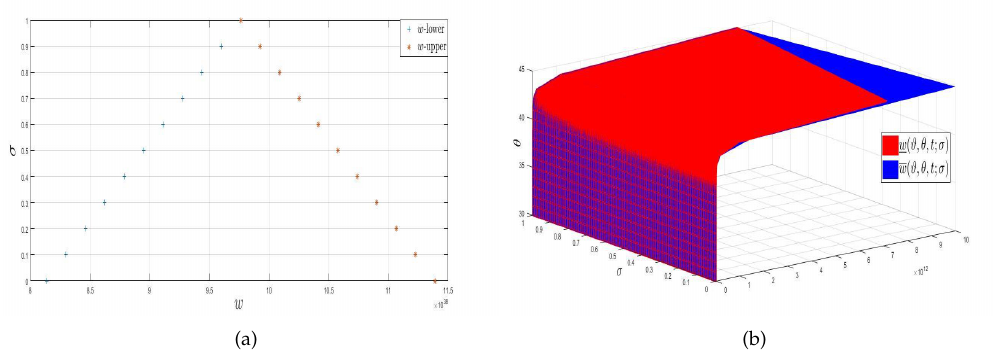
Figure 1. The exact lower and upper solutions of Equation (111) at ϑ = 30, θ = 45, t = 60, ρ = 1, n = 1. ( a ) 2 D figure for exact solution of fuzzy ZK ( 2,2,2 ) equation of w in Example 5. 1905; ( b ) 3 D figure for exact solution of fuzzy ZK(2,2,2) equation of w in Example